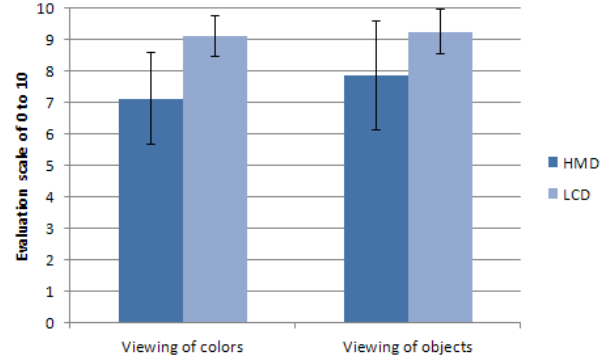
Fig. 11. Subjective levels of quality in color definition and object border visualization in the rendered virtual environment.